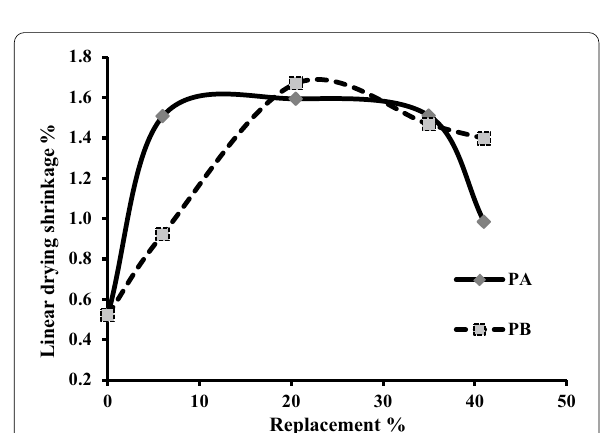
Fig. 5 Effect of PA and PB addition on the linear drying shrinkage